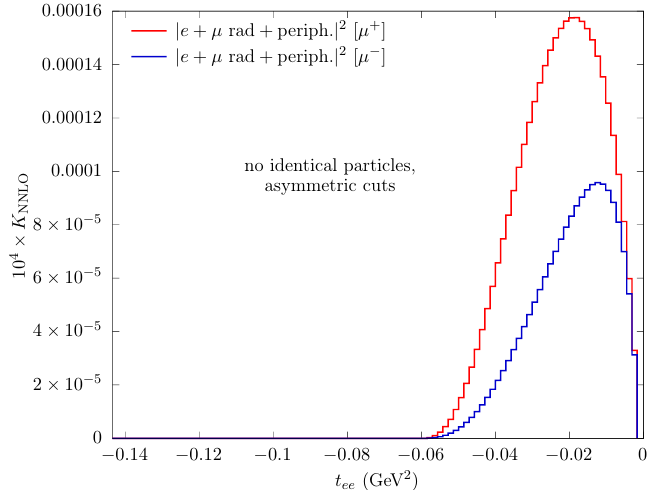
Figure 18. Impact of the µ ± e − → µ ± e − µ + µ − process on the t ee distribution, for the academic selection